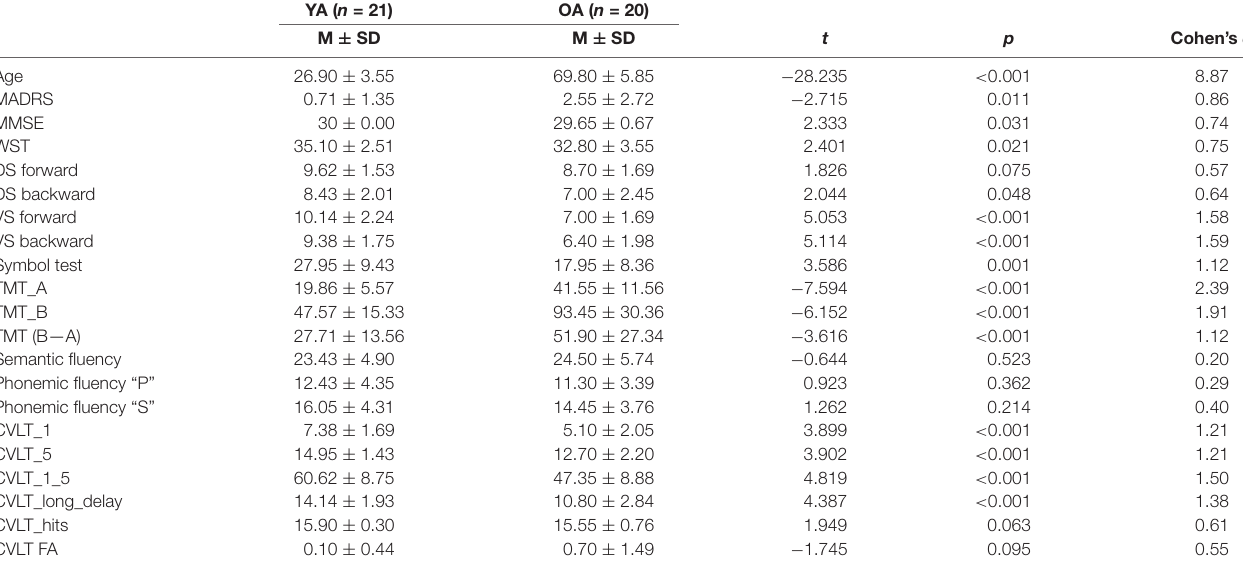
TABLE 2 | Demographic and neuropsychological variables of young adults (YA) and older adults (OA).